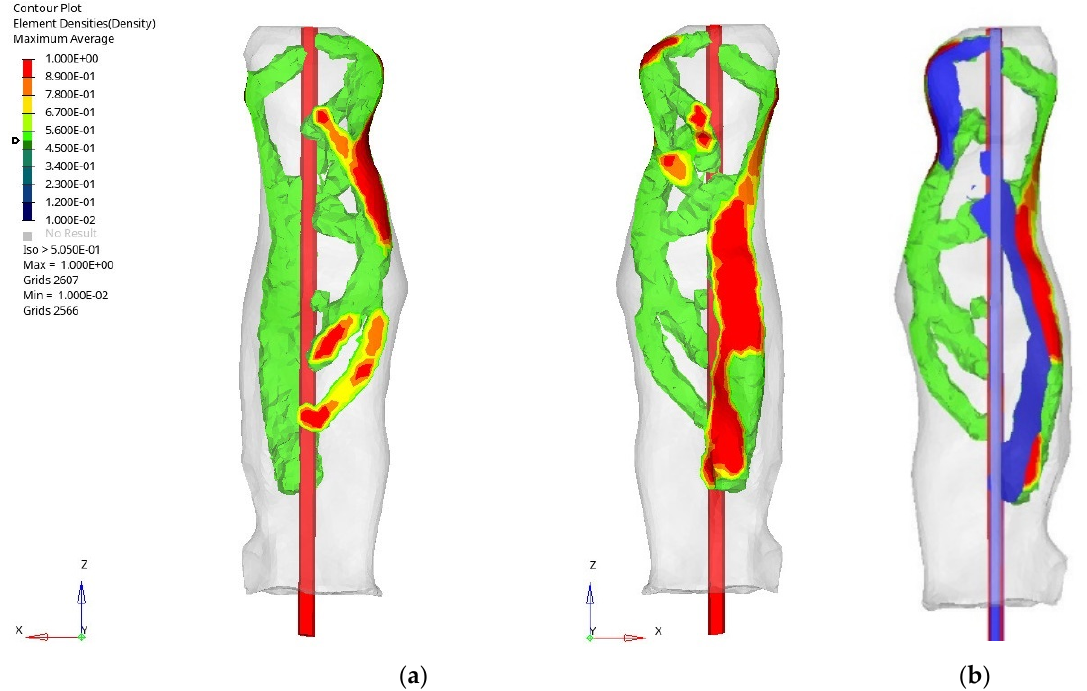
Figure 8. CBWA_Sa case: density distribution ( a ) Back and front View) ( b ) Two intersecting sectional views (in blue).